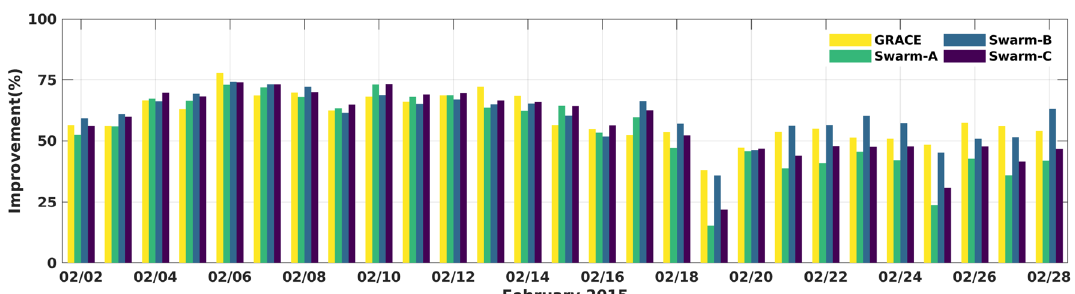
Figure 6. An overview of improvements in percent, which is used to assess the performance of the C/DA based on GRACE-TNDs as observation in the C/DA framework during February 2015. The figure was generated using MATLAB (version R2021a, https:// www. mathw orks. gous to the equatorial ionosphere anomaly (EIA) 72 , ETA is formed around the local noon. Various mechanisms are named as drivers of ETA namely heat transport due to zonal winds, chemical heating, and field-aligned ion drag 73 . ETA is then represented as a function of local time, season, geomagnetic and solar activity index. To illus- trate the effect of C/DA on representing ETA, the differences between are computed during different local times. The differences polar map for the altitude of 450 km are depicted in Fig. 9 on February 8th, 2015 with relatively high solar activity. The patterns of difference between TNDs from 11:00 to 19:00 LT indicate that the peak values